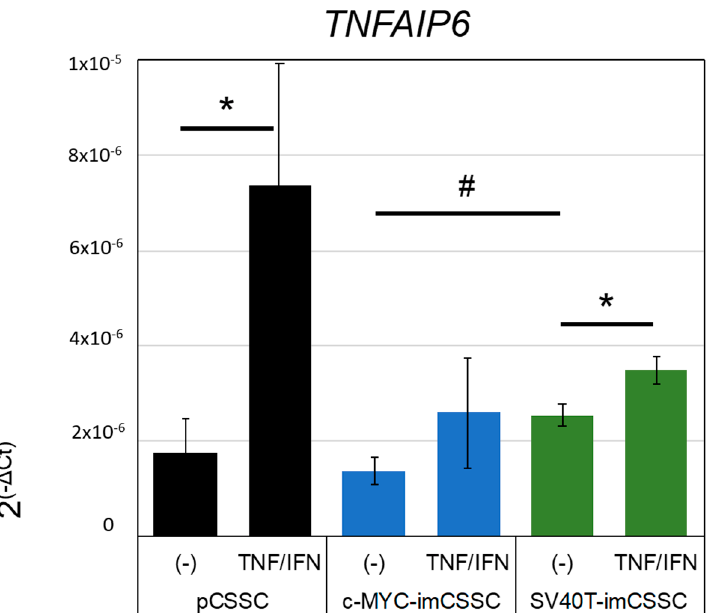
Figure 5. Anti-inflammatory properties. Anti-inflammatory response of pCSSC (p3 to 4), SV40T- imCSSC, and c-MYC-imCSSC cells (p8 to 12 for imCSSCs) after stimulation (TNF/IFN) with pro- inflammatory cytokines, IFN- γ (25 ng/mL) and TNF- α (10 ng/mL), as quantified by TSG-6 transcript levels ( TNFAIP6 ) analysis as tested by RT-PCR. Results are expressed as mean ± SEM ( n = 3). Statistical analysis: ANOVA followed by Student’s t -test comparison of means, * p -value < 0.05 between control untreated ( − ) and stimulated cells (TNF/IFN) for each cell line; ANOVA followed by all-pair comparisons Tukey’s test, # p -value < 0.05 between each cell line unstimulated. CSSC: corneal stromal stem cell; pCSSC: primary CSSC; imCSSC: immortalized CSSC; SEM: standard error of the means.